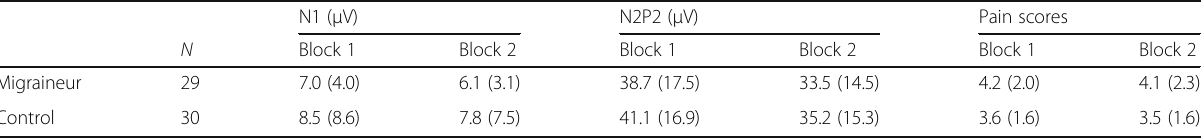
Table 4 N1 and N2P2-amplitudes, and pain scores in migraineurs in the interictal phase and controls